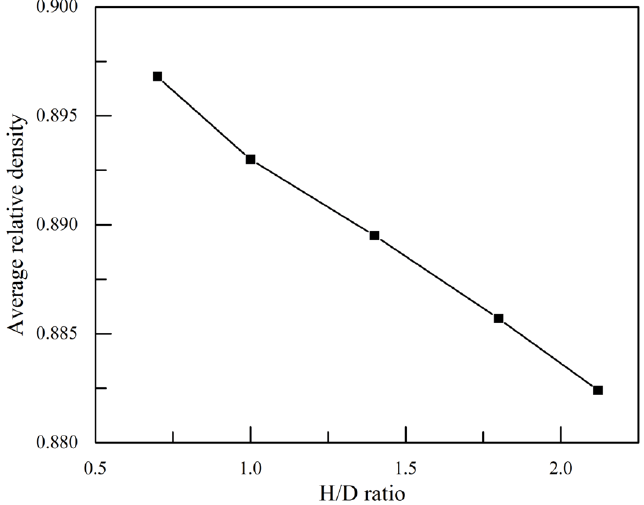
Figure 28. Variation of average relative density with H/D ratio.